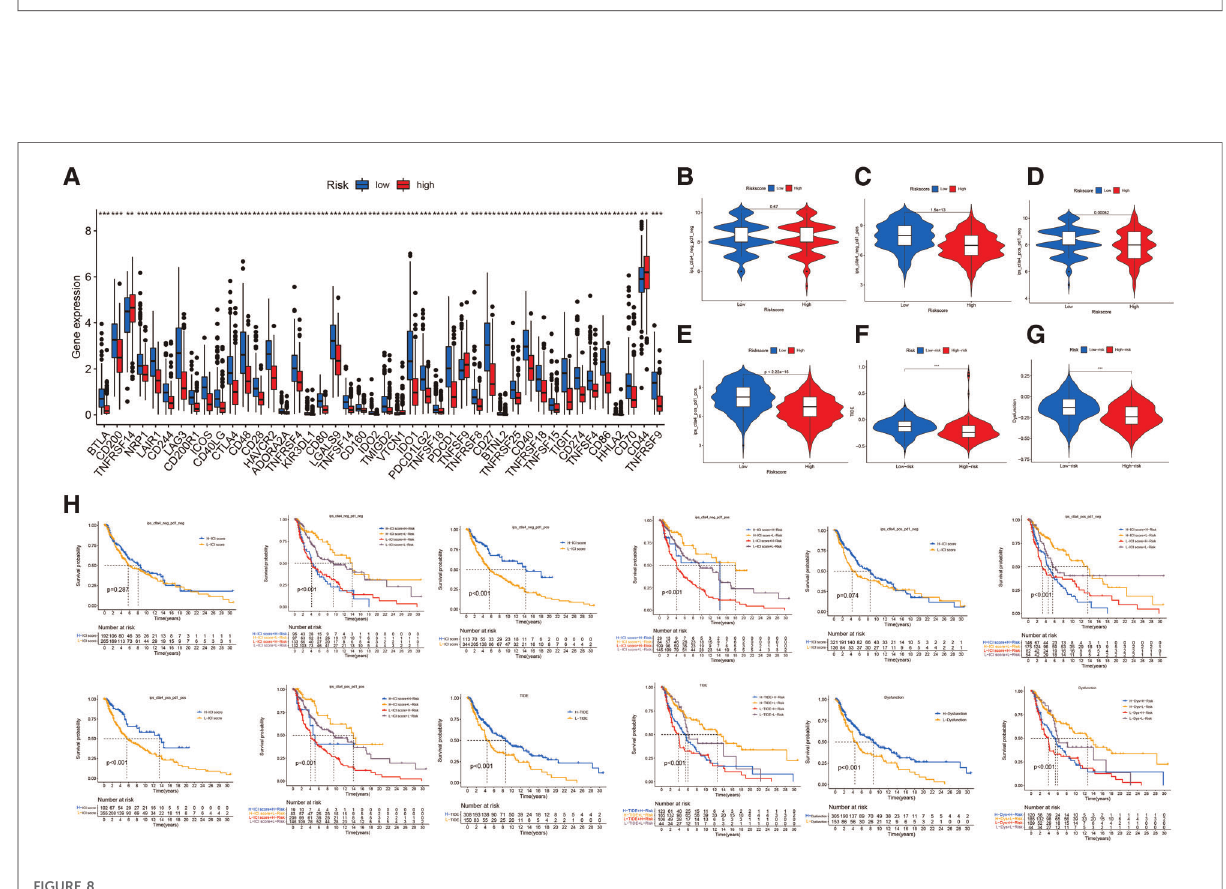
FIGURE 8 Immune checkpoint differences. ( A ) The expression of 44 immune checkpoint genes differed signi fi cantly between the high- and low-risk groups. The low-risk group had signi fi cantly higher expression of CD274 ( PDL-1 ) and CLAT-4 ( P <.001). ( B ) The difference in ICI ef fi cacy was not signi fi cant between the 2 groups if PD-1 and CLAT4 were both negatively expressed. ( C – E ) Low-risk patients with PD-1 or CTLA4 expression were likely to respond better to ICIs than high-risk patients were. ( F,G ) The TIDE and Dysfunction scores were higher in low-risk group than high-risk group. ( H ) The prognostic performance in immunotherapy